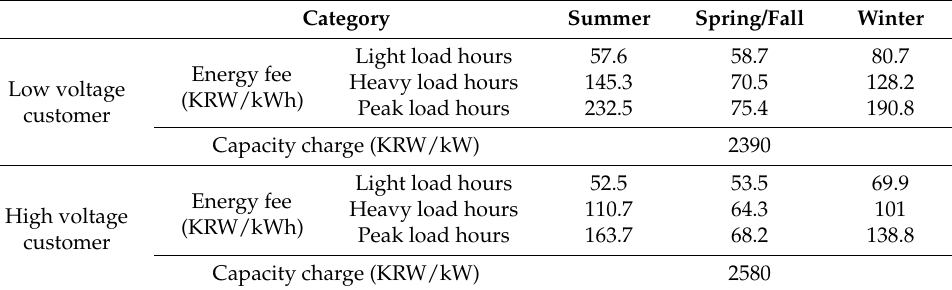
Table 2. Specific values for EV charging fee in